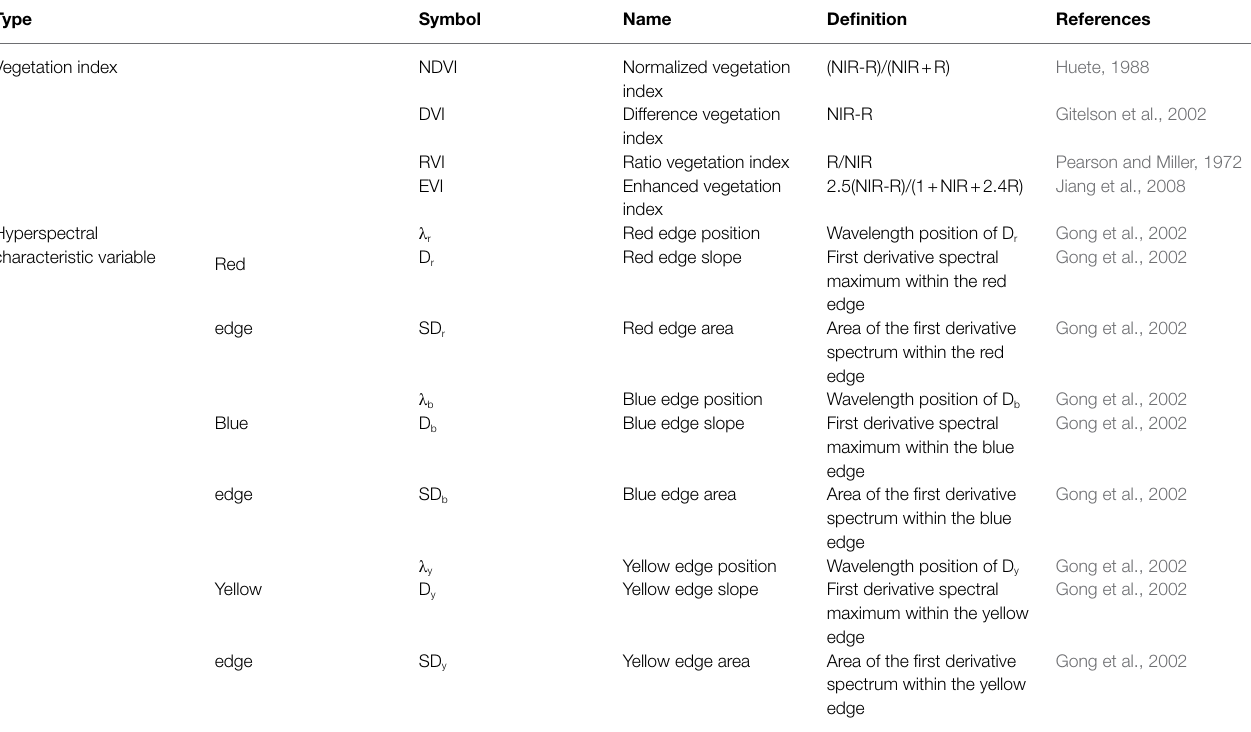
TABLE 1 | Spectral